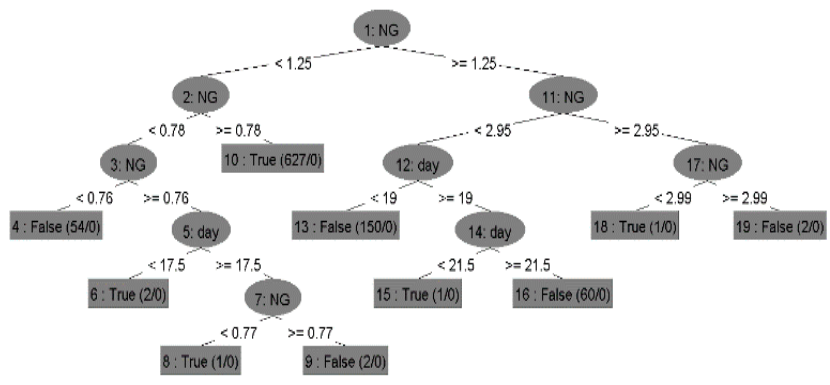
Figure 13. Visualized tree with random tree.